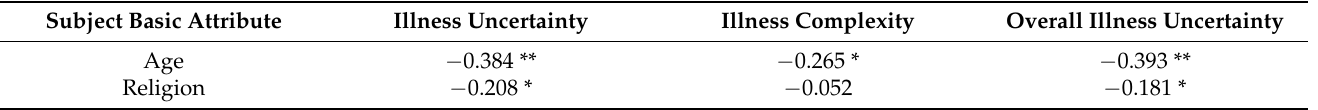
Table 4. Correlation between subjects’ basic attributes and illness